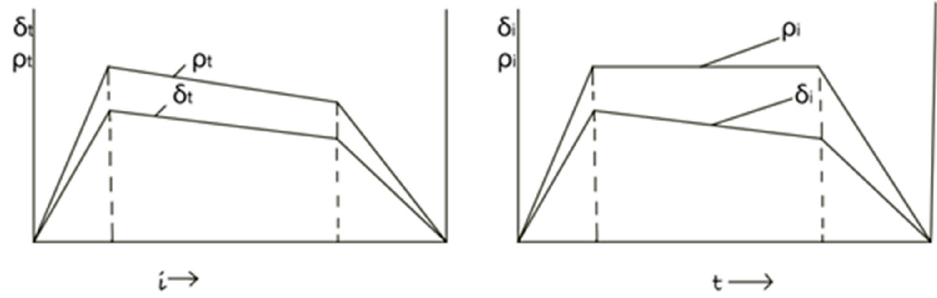
Figure 2. Conventional method for reducing rate and reduction distribution.